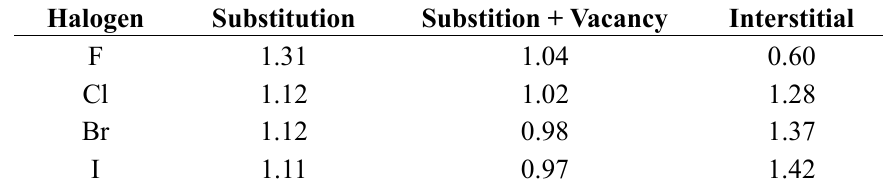
Table 6. Formation energies in eV for the compositions of In 4 Se 2.94 H 0.06